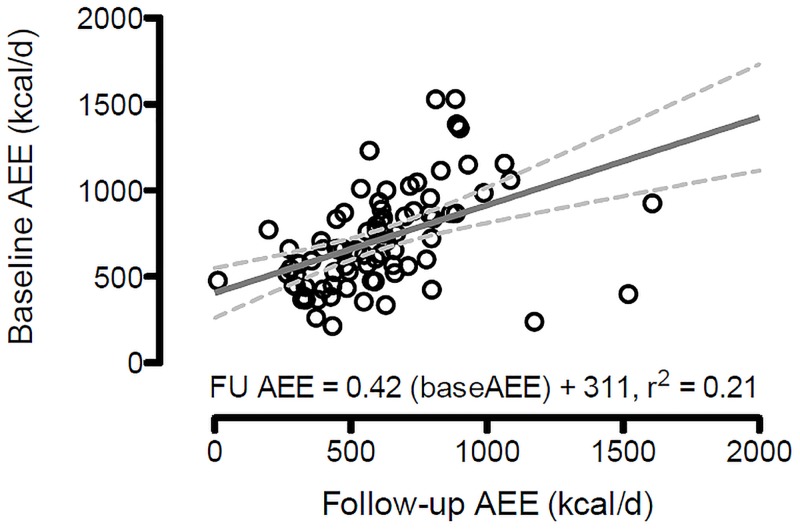
Scatterplot and line of best fit for baseline and follow-up activity energy expenditure.